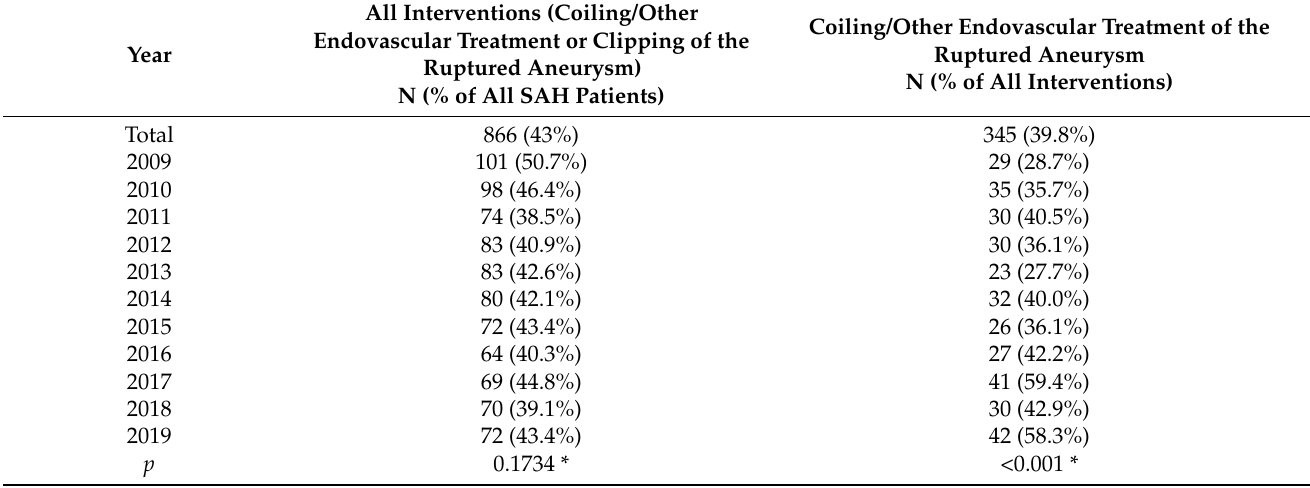
Figure 2. Percentage of SAH patients hospitalized in the neurosurgical departments of the Silesian Province between 2009 and 2019 (Cochran–Armitage trend test: p = 0.009).